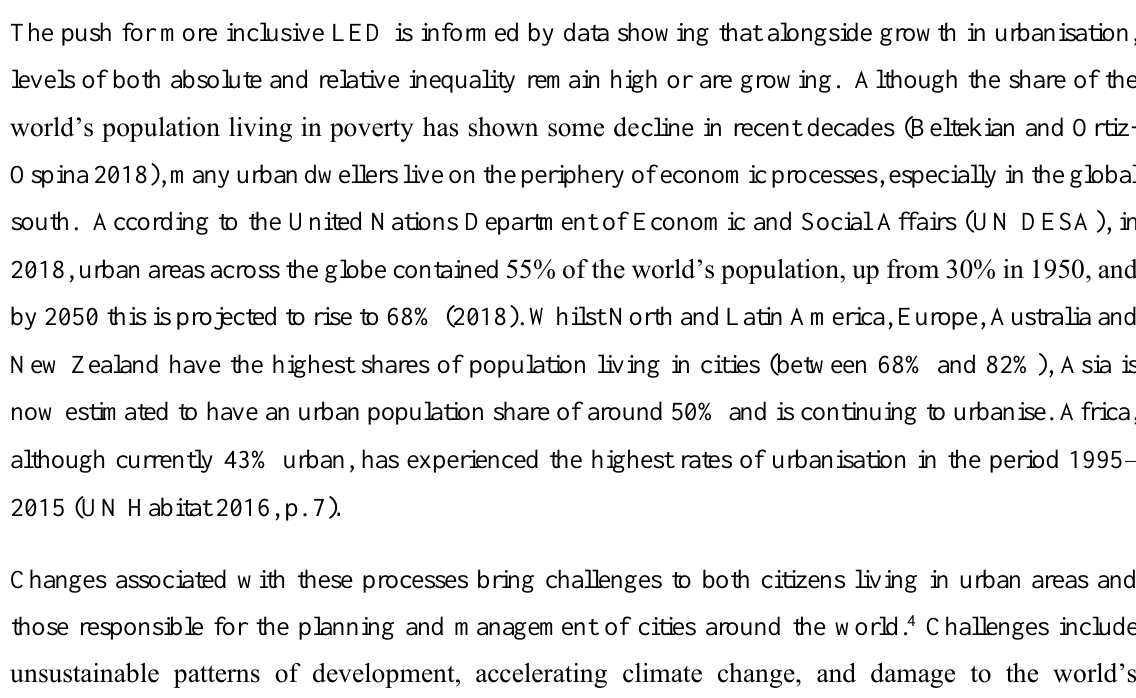
Source: Benner et al. (2018, p.